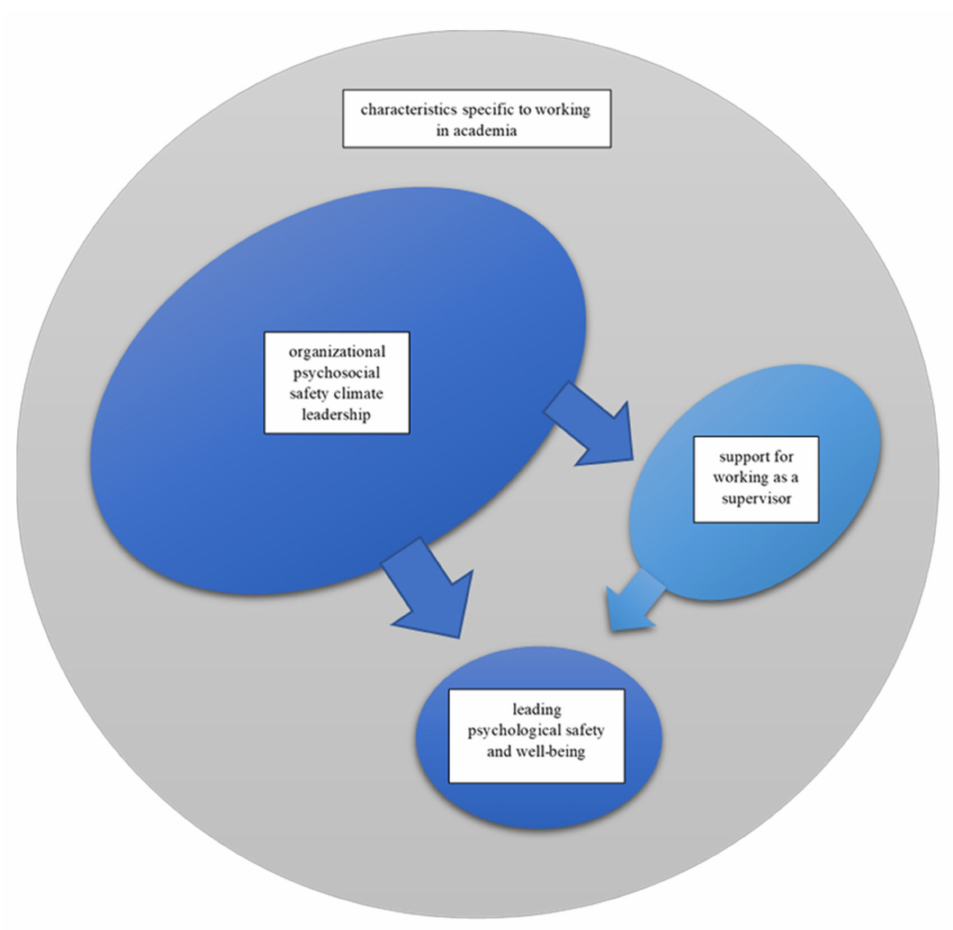
Figure 1. The interconnections between the main